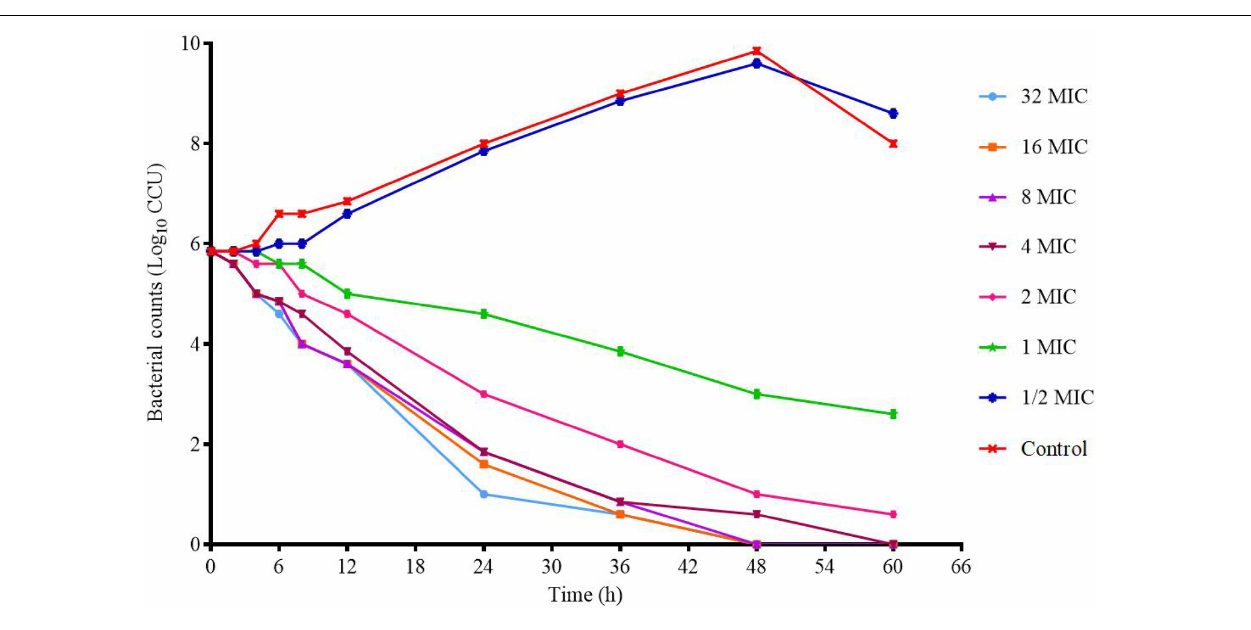
FIGURE 3 | In vitro killing–time curves of tylosin against